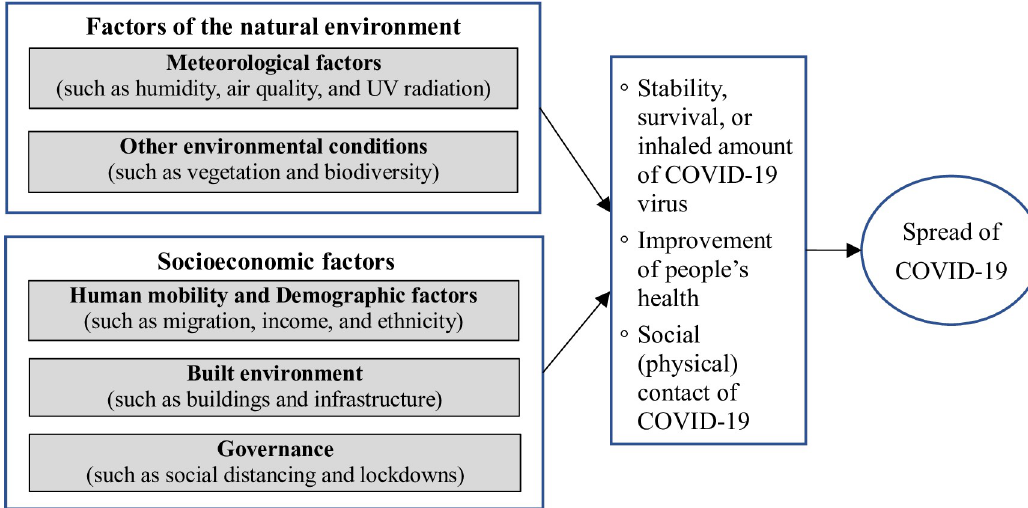
Fig 1. Important impact factors of the COVID-19